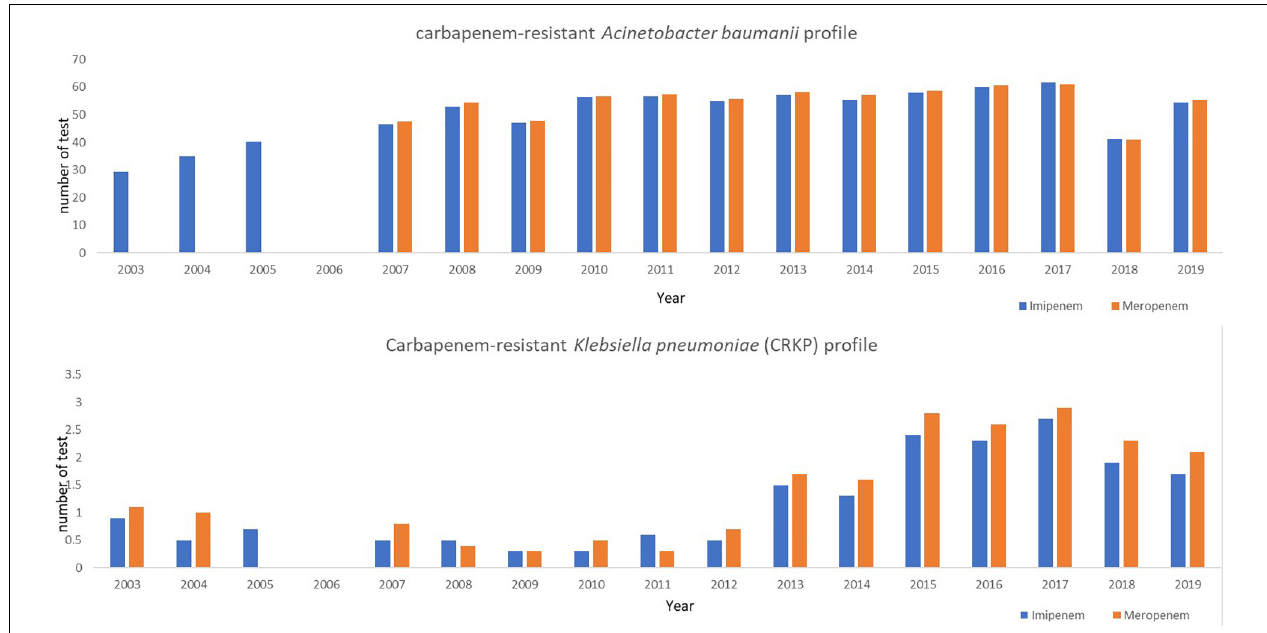
FIGURE 1 | Carbapenem-resistant Acinetobacter baumanii and Klebsiella pneumoniae (CRKP) antibiotic resistance profile (NSAR